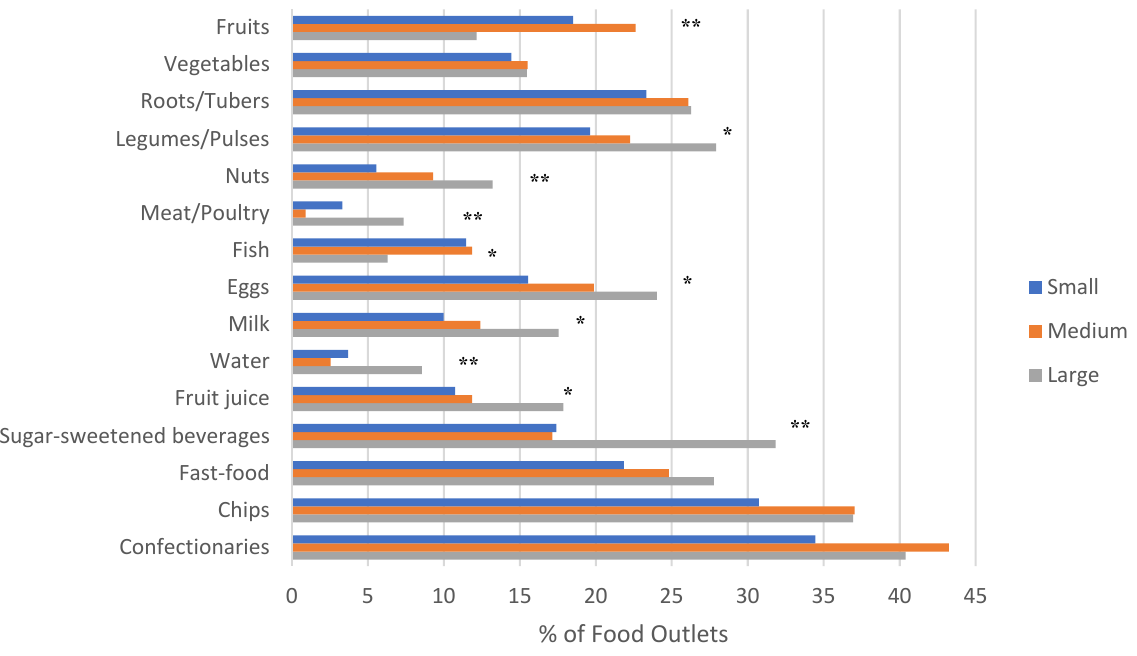
Figure 3. Proportion of Food Outlets with Available Food Items by Village Size. χ 2 test, * = p < 0.01; ** = p < 0.001. Table 4. Food Availability by Food Outlet Type.